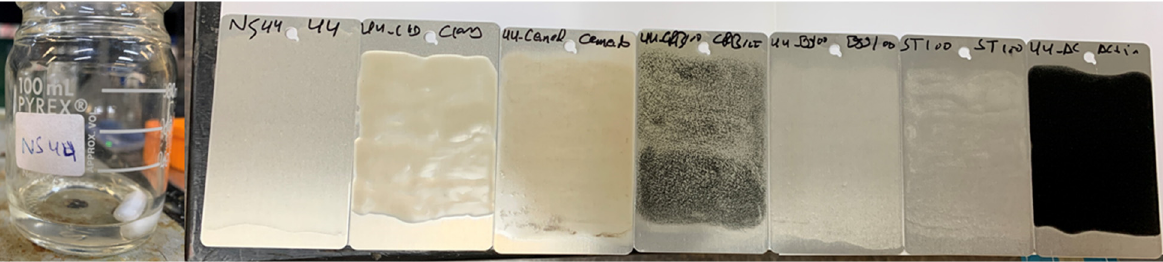
Figure 2. Physical appearances of the neat hybrid polymer (left) and the cured coating formulations